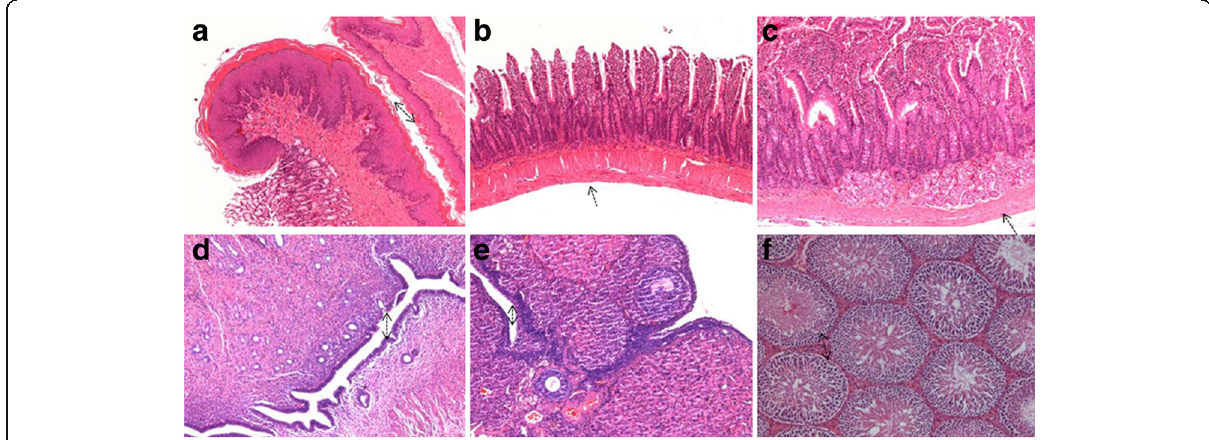
Fig. 11 Histopathological analysis of organs stained with H&E. Histopathology showing normal morphology from rats treated with Jueyin granules at the dose of 7.5 g/kg/day. a stomach, b jejunum, c duodenum, d uterus, e ovaries, f orchis; scale bar = 100 μ